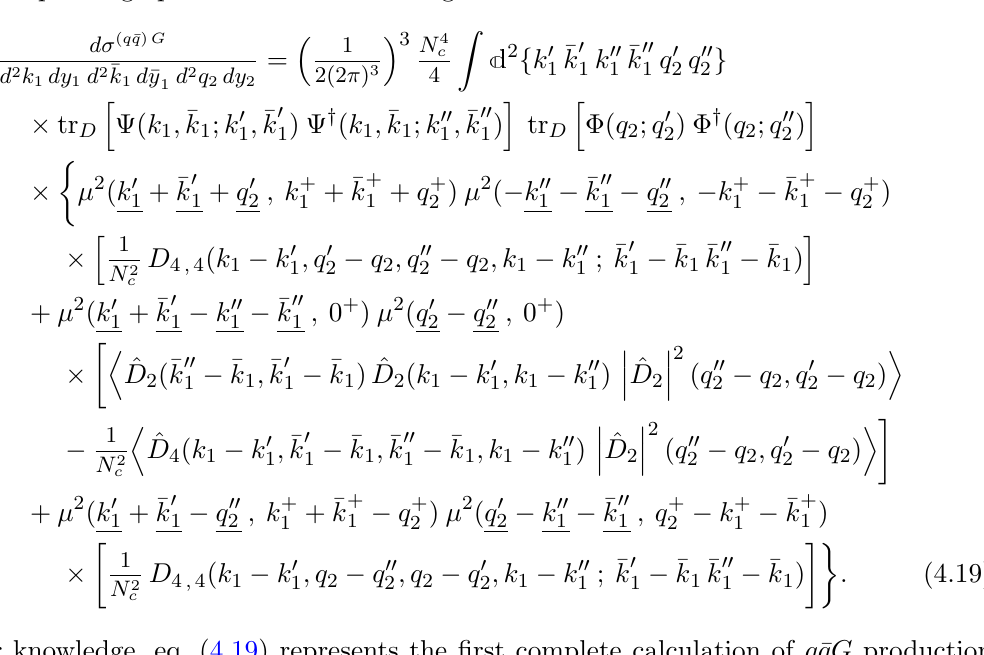
Figure 7 . Illustration of the Wilson line traces q (cid:22) qG production in eq.